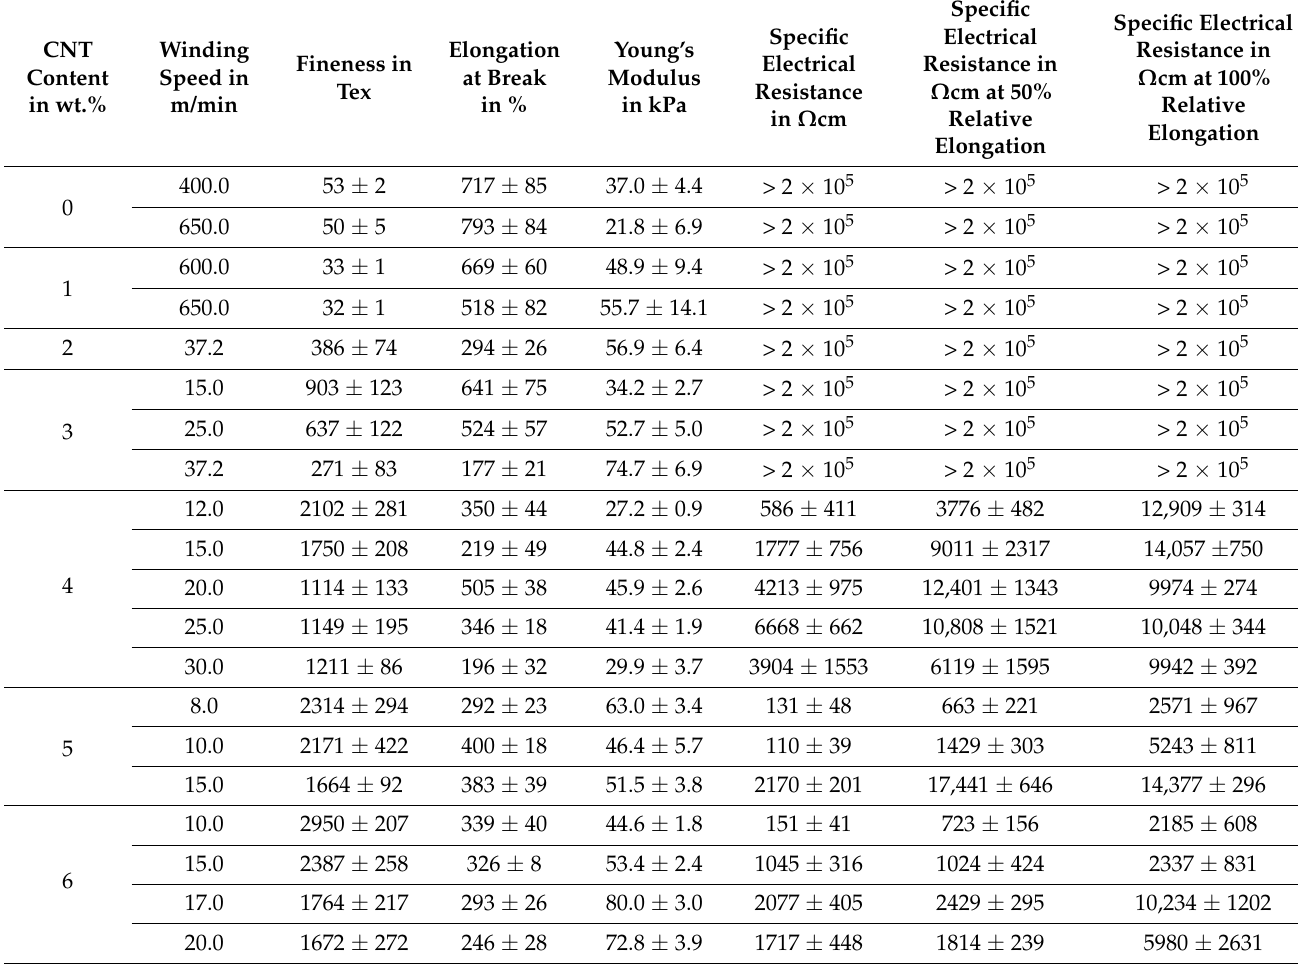
Table 1. Mechanical and electrical properties of TPU–CNT